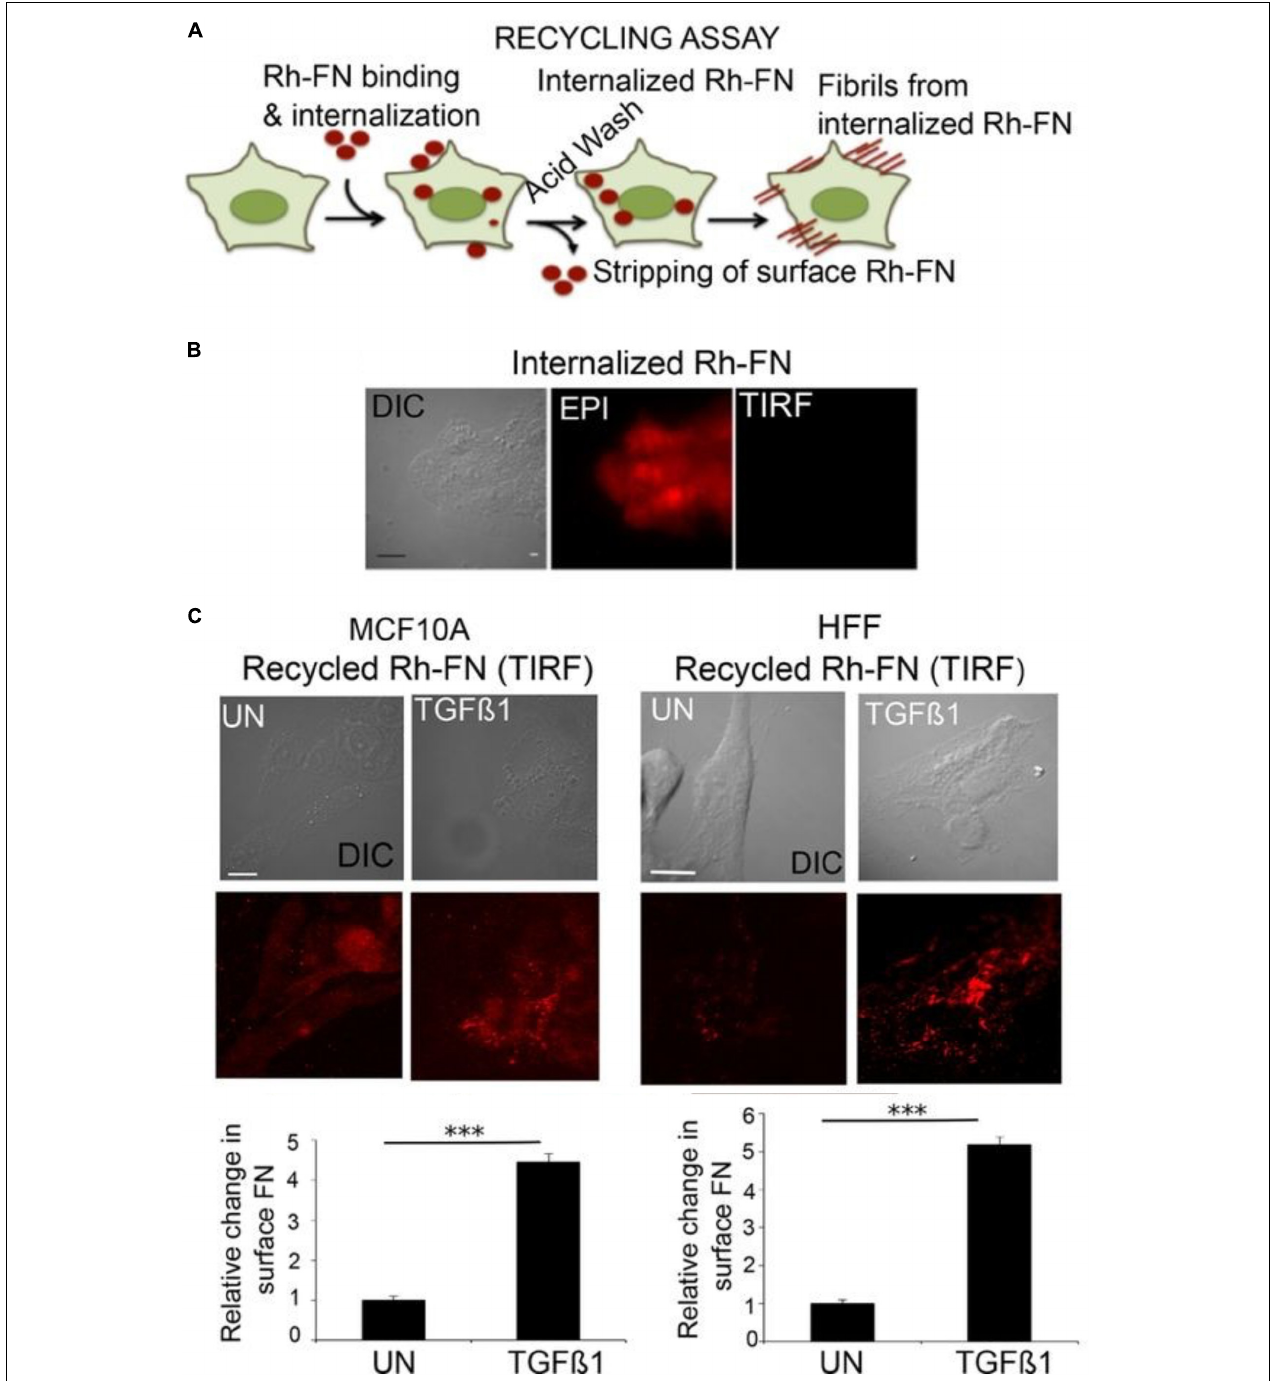
FIGURE 2 | Fibronectin recycling in epithelial cells. (A) Schematic of the assay used to assess fibronectin recycling. Live cells were incubated with Rh-FN (rhodamine-labeled fibronectin) for 30 min at 37 ◦ C. The cells were then stripped by acid washing to remove surface-bound molecules, so that only signal from internalized Rh-FN remains. Afterward, the cells were incubated in medium containing TGF- β 1 for 1 h at 37 ◦ C, and then imaged using total internal reflection (TIRF) microscopy to assess the appearance of the internalized Rh-FN at the cell surface. (B) Following the incubation with Rh-FN, the cells were imaged both in TIRF mode or with epifluorescence to verify that the molecules had internalized. (C) The amount of resurfacing Rh-FN was assessed in TGF- β 1-treated MCF10A breast epithelial cells or human foreskin fibroblasts (HFF), demonstrating that TGF- β 1 induces significant recycling of FN in both cell types. Scale bar = 5 µ m. The quantifications below the images were performed using the ImageJ 3D Object Counter plug-in. N = 10 cells per condition from at least three independent experiments. *** p < 0.001. Adapted from Varadaraj et al. (2017) with permission from the American Society for Cell Biology.